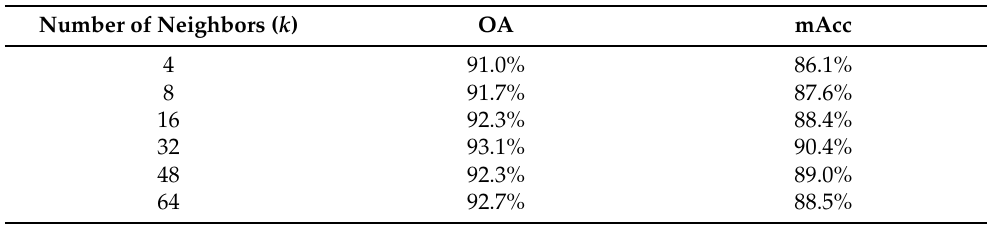
Table 8. Ablation study: classification accuracy of TR-Net on ModelNet40 test set with k neighbors in the definition of local